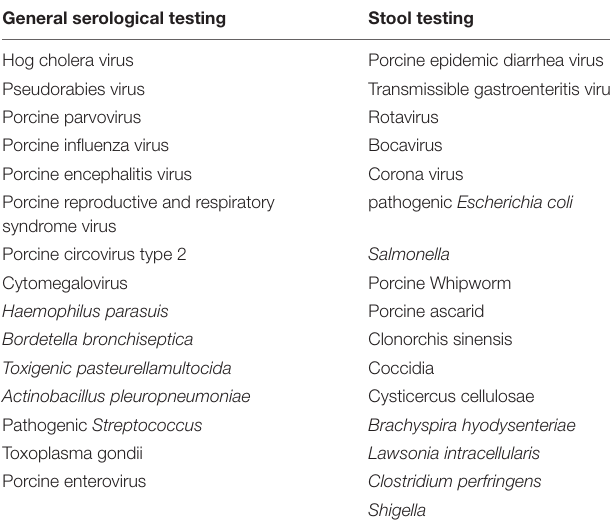
TABLE 2 | General serological testing and stool testing to monitor potentially infectiouspathogens. General serological